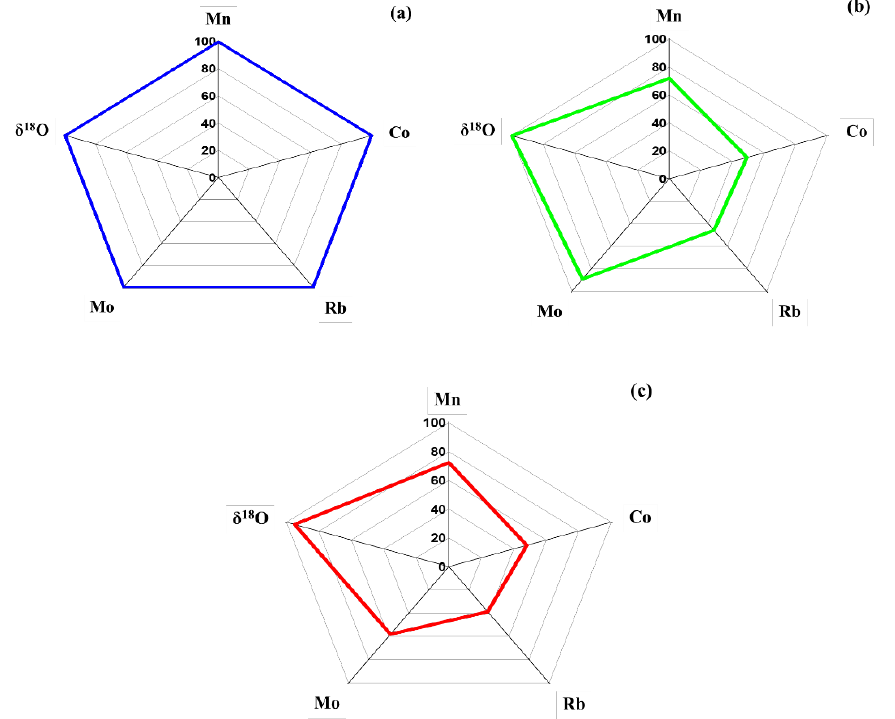
Figure 4. Radar plots summarizing the difference as relative concentration of the studied variables (Mn, Co, Rb, Mo, and δ 18 O) in THMR from ( a ) YP, ( b ) RP, and ( c )